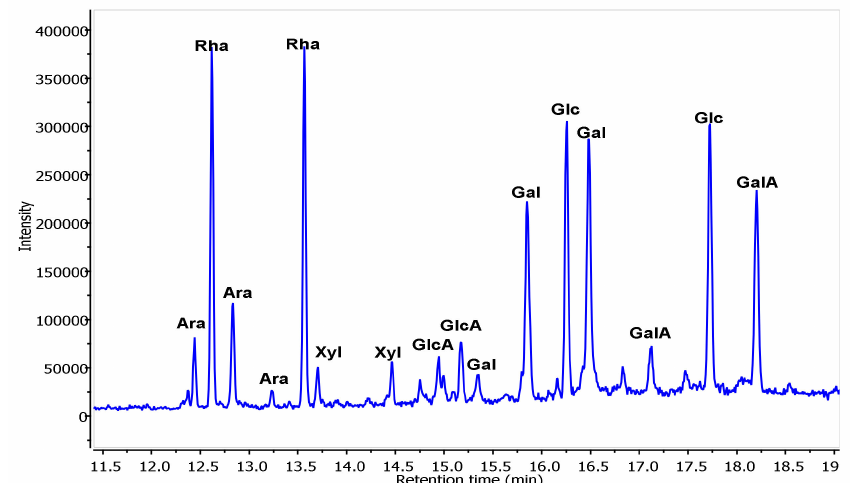
Figure 2. Gas Chromatography / Mass Spectrometry - Electronic Impact (GC / MS-EI) (70 eV) total ion chromatogram of trimethylsilyl- O -glycoside residues prepared from